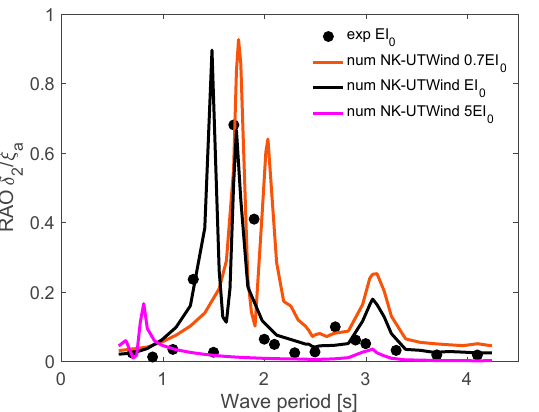
Figure 15. RAO punctual displacement due to the elastic deformation at the tower top result com- parisons between the experiment and NK-UTWind numerical calculation for different structural rigidities.